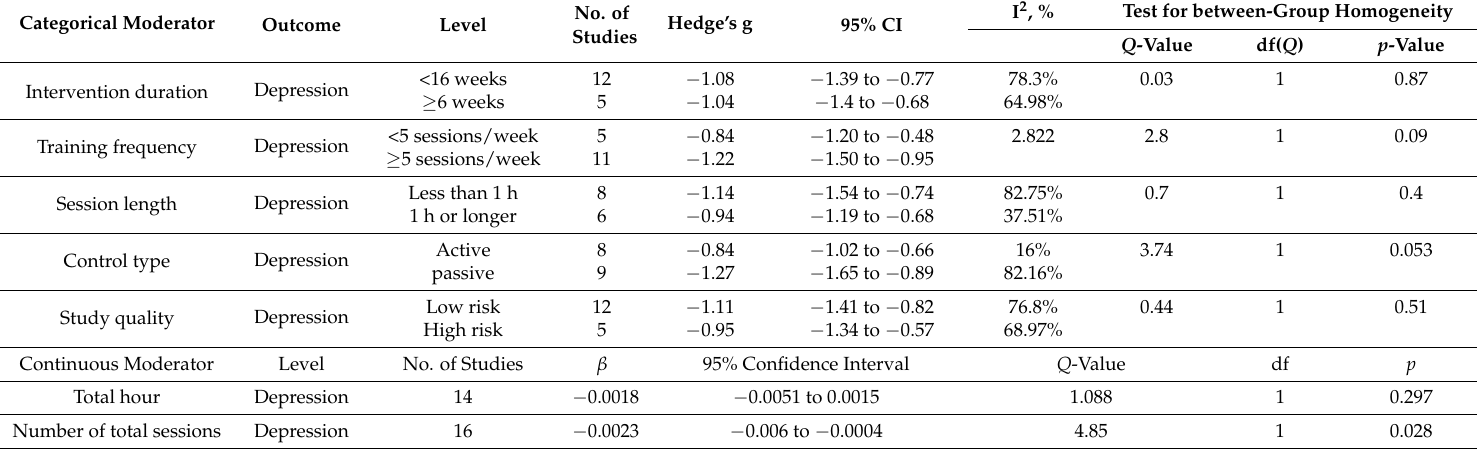
Table 5. Moderator analysis for Baduanjin versus control